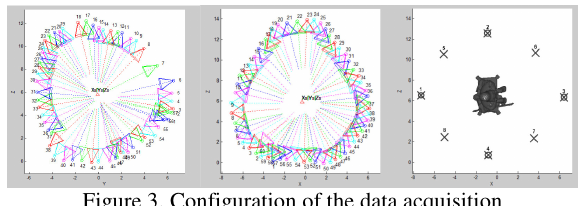
Figure 3. Configuration of the data acquisition